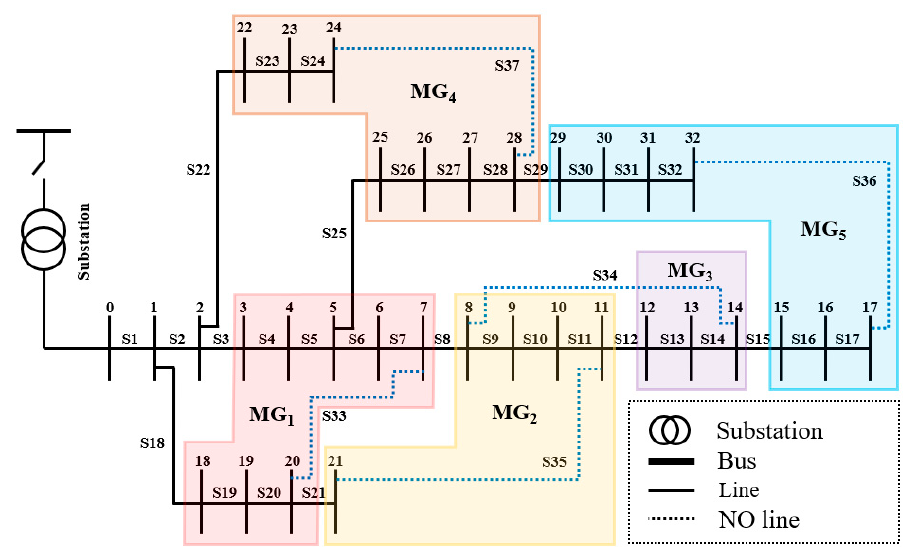
Figure 1. A single-line diagram of standard IEEE 33-bus radial distribution system (RDS).